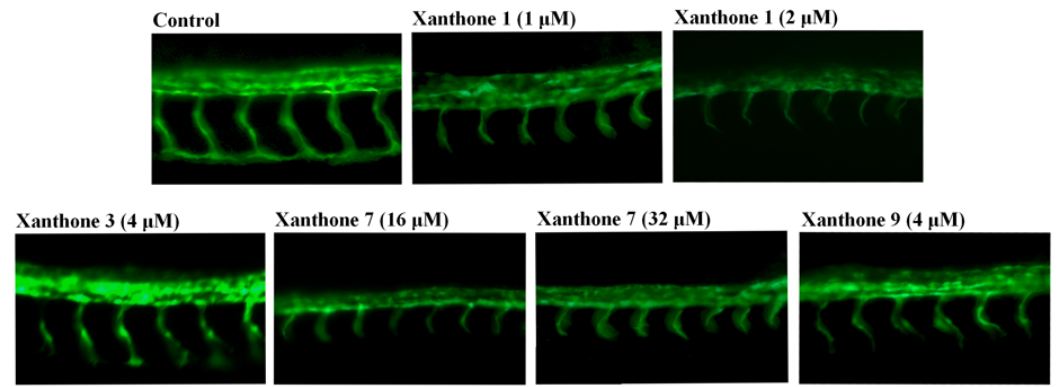
Figure 2. Antiangiogenic effect of xanthones 1 , 3 , 7 and 9 in zebrafish embryos. (magnification 400×) The results shown are representative of three independent